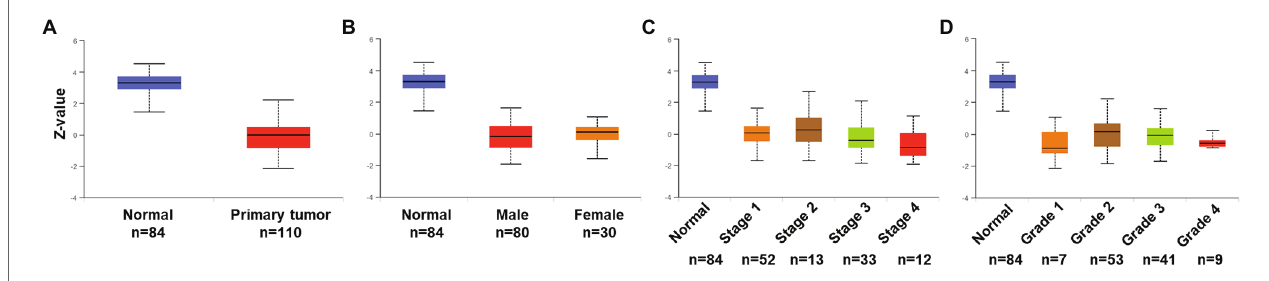
FIGURE 5 | Association of PATJ protein level with pathological features from ccRCC patients. (A) Downregulation of PATJ in ccRCC tissues. (B) Association of PATJ with patients’ gender. (C) PATJ with ccRCC stages. (D) PATJ with ccRCC grades. The box plots and values of p ( Table 3 ) in A–D were generated by using the UALCAN (http://ualcan.path.uab.edu/index.html).